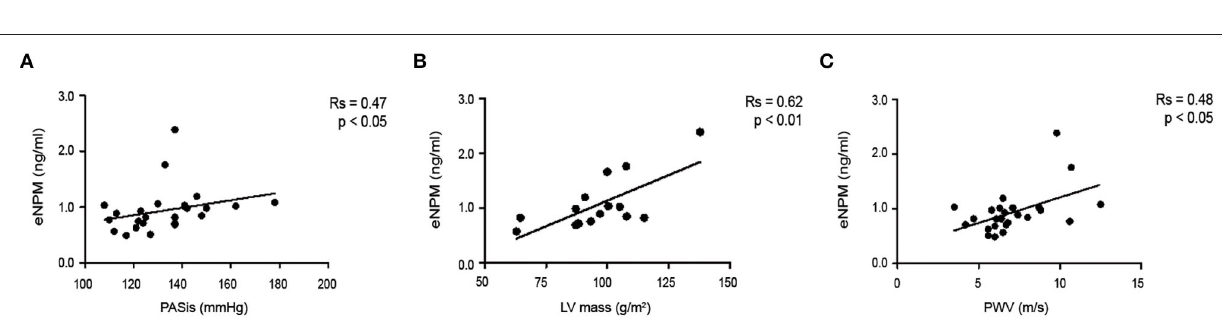
with PASis, LV mass index, and PWV, which is a gold standard non-invasive measurement of arterial stiffness